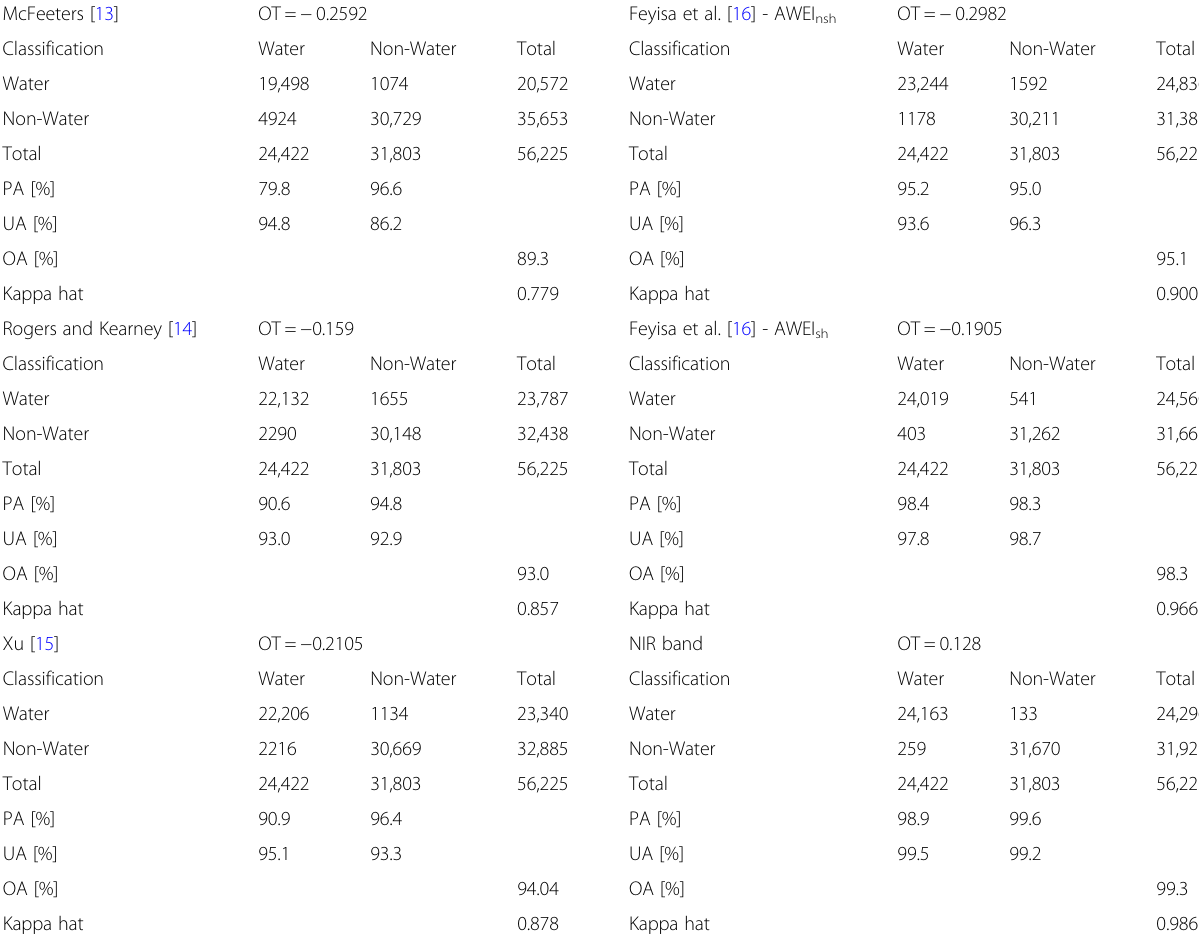
Table 3 Confusion matrix of different water indexes. OT means Optimum Threshold McFeeters [13] OT = −